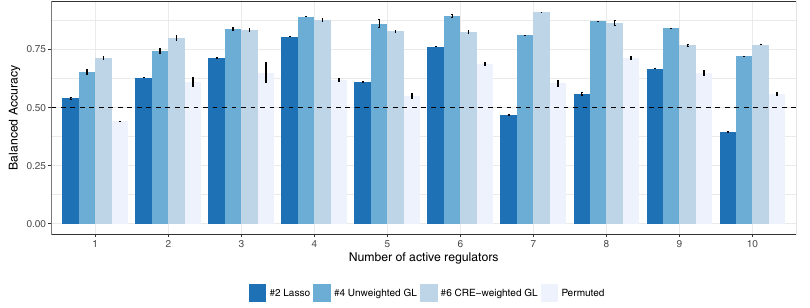
Figure 3. The bar plots show the achieved balanced accuracy in simulated test data for method #6 CRE- weighted group-lasso using the original network and the permuted network in contrast with #2 lasso-based logistic regression as well as #4 Unweighted group-lasso. Across all 10 runs, our method is able to exploit the network-structure to improve performance with respect to lasso-based regression. For a random network, performance deteriorates to the level of lasso-based